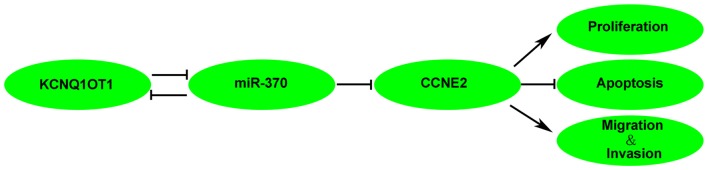
The schematic cartoon of the mechanism of KCNQ1OT1 negatively regulated miR-370/CCNE2 axis in glioma.